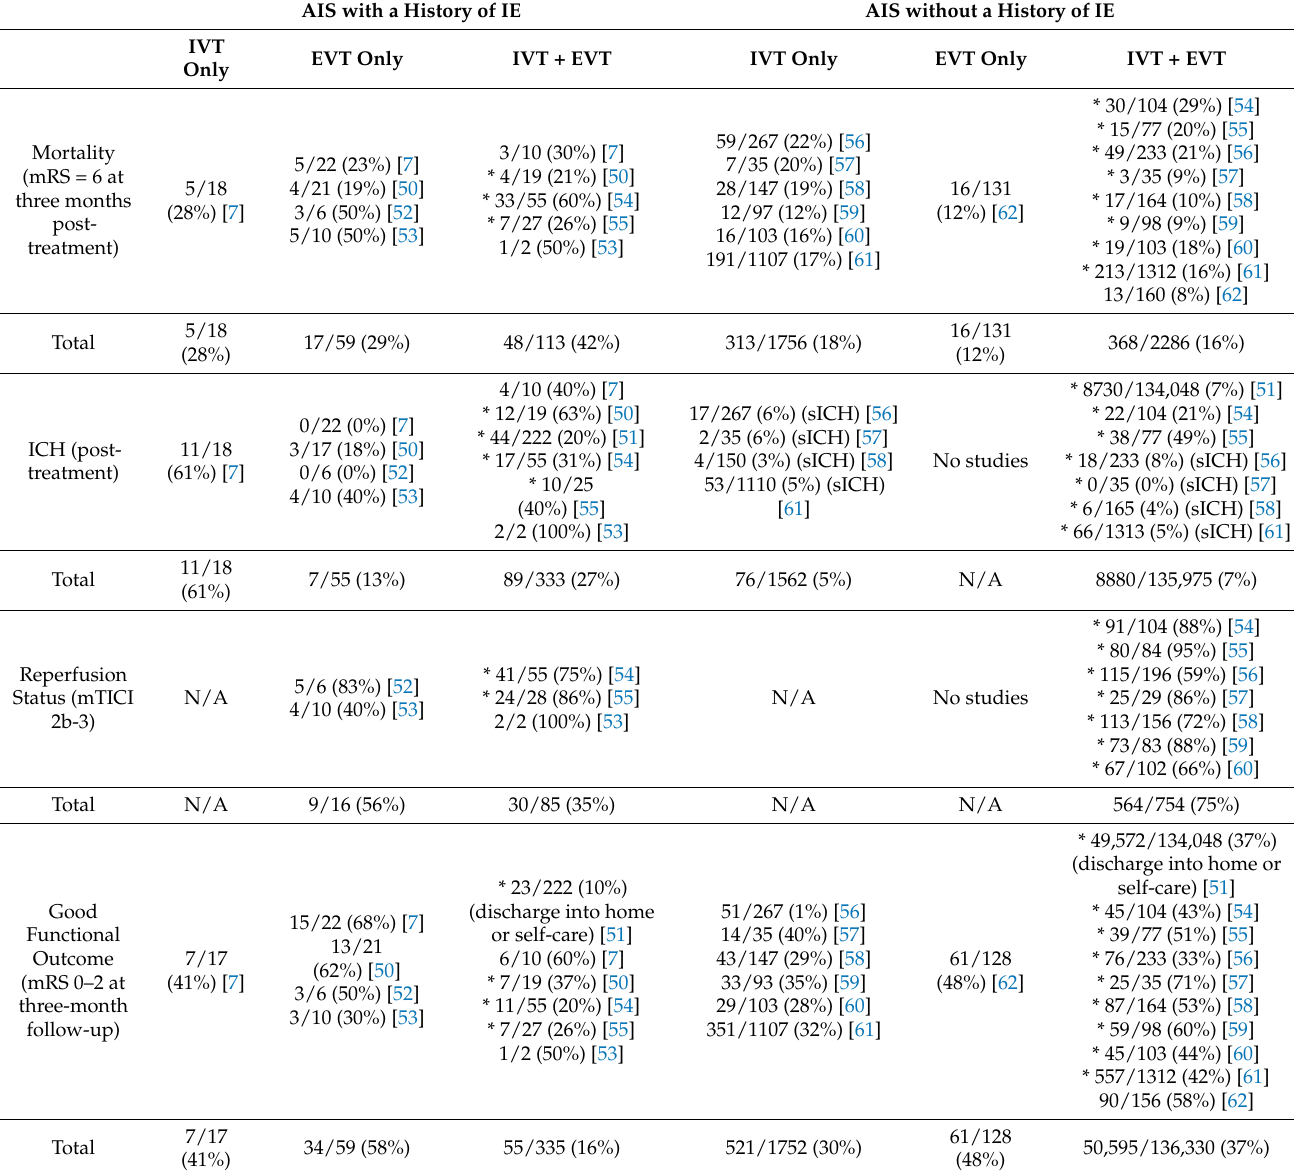
Table 1. Outcomes of acute ischaemic stroke in patients with and without infective endocarditis. AIS with a History of